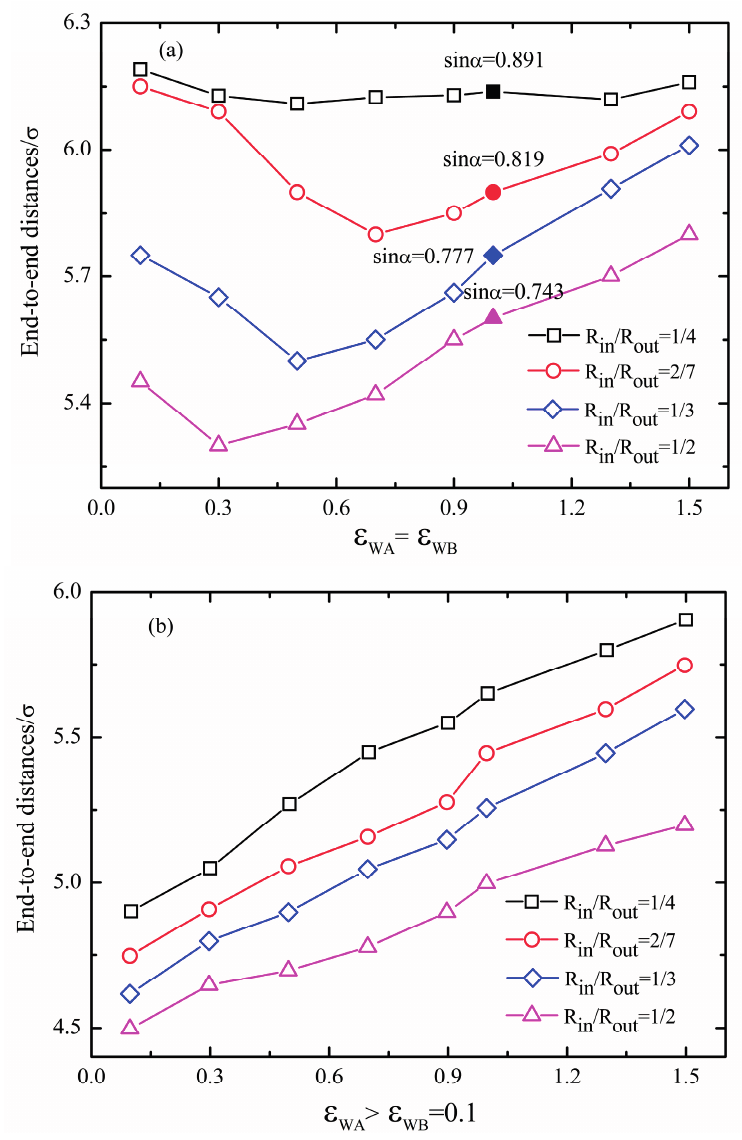
Figure 6. Variations in end-to-end distances of copolymers confined in multi-walled nanotubes when ( a